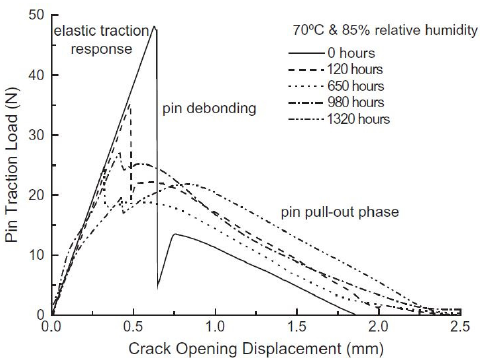
Figure 34. Pull-out load-displacement curve of z-Pins with time exposure in 70 ◦ C and 85% humid environment (CFRP z-Pins, 4.0 vol%, d = 0.28 mm, pseudo-quasi-isotropic pre-preg, t = 4.5 mm) [38].